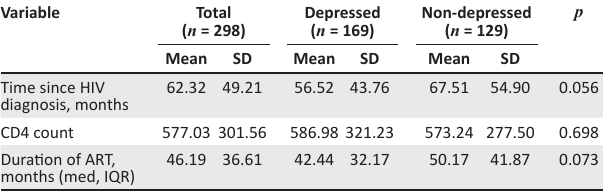
TABLE 2a: Clinical status of depressed and non-depressed participants.